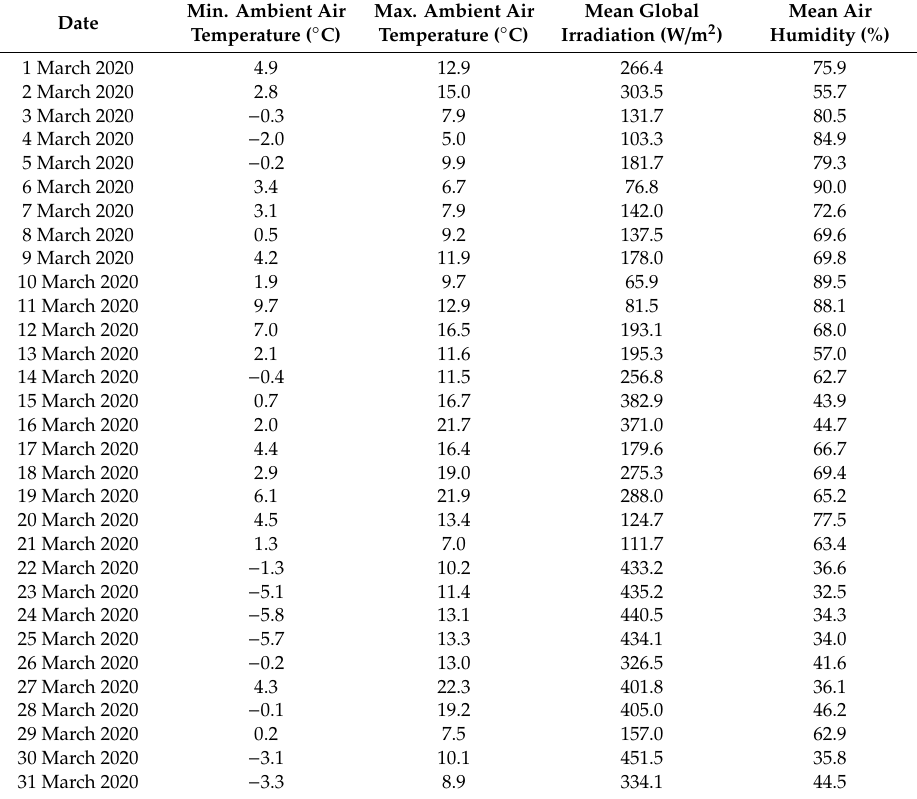
Table A4. Measured boundary conditions in March